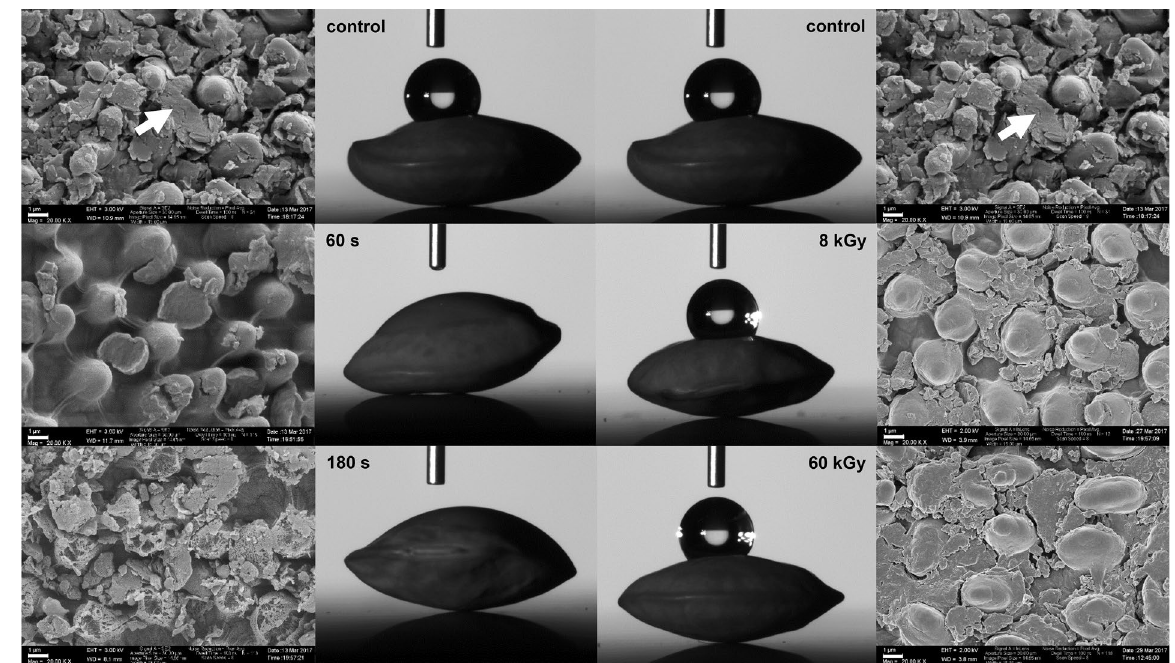
Figure 6. Scanning electron micrographs of the surface topology of CAP treated (left) or LEEB treated (right) lentil seeds. Scale bars represent 1 µm. Time of plasma exposure is indicated in the top left or right corner of the images. White arrows indicate embedded debris observed between the papillae of untreated seeds used as control. While seeds exposed to 60 s of CAP treatment revealed visible concave pits that were cleared from such debris, even high dose electron beam treatment did not remove the debris lodged between the protruding structures on the lentil seed surface. After 180 s CAP treatment, the seed surface revealed erosion of the protruding structures. The middle part of the figure displays the impact of CAP (left) or LEEB (right) treatment on the wettability of the lentil seeds shown with water droplet and contact angle measurements. Untreated control seeds showed a hydrophobic surface. While the surface of CAP treated seeds became hydrophilic, LEEB treated seeds maintained hydrophobic surface characteristics. SEM images provided by Stephan Handschin, CC by